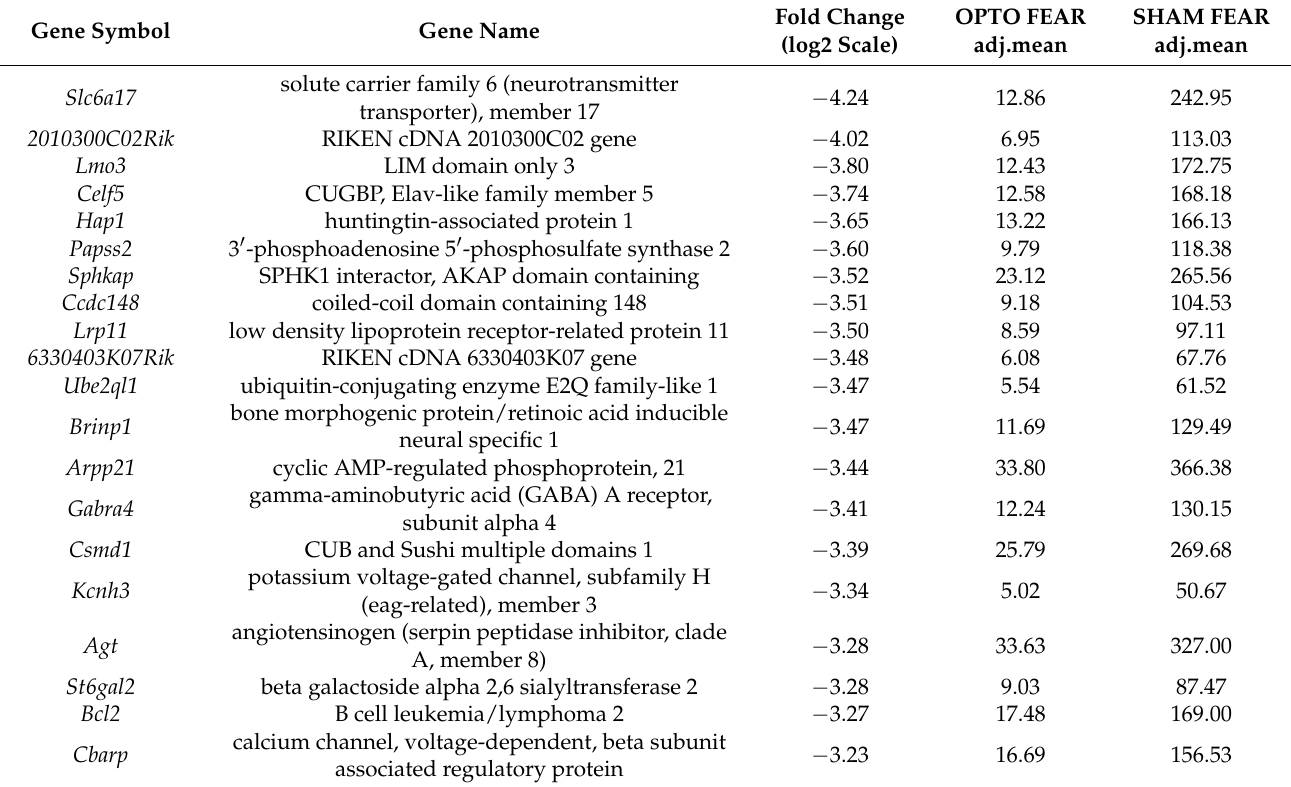
Table 1. The top 20 DEGs identified by differential expression profiling from RNA extracted by amygdala pyramidal neurons. Comparison between OPTO FEAR vs. SHAM FEAR